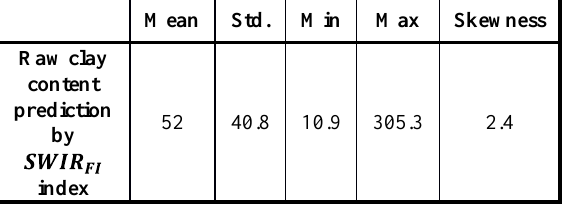
Table 3: Distribution of raw clay content predictions